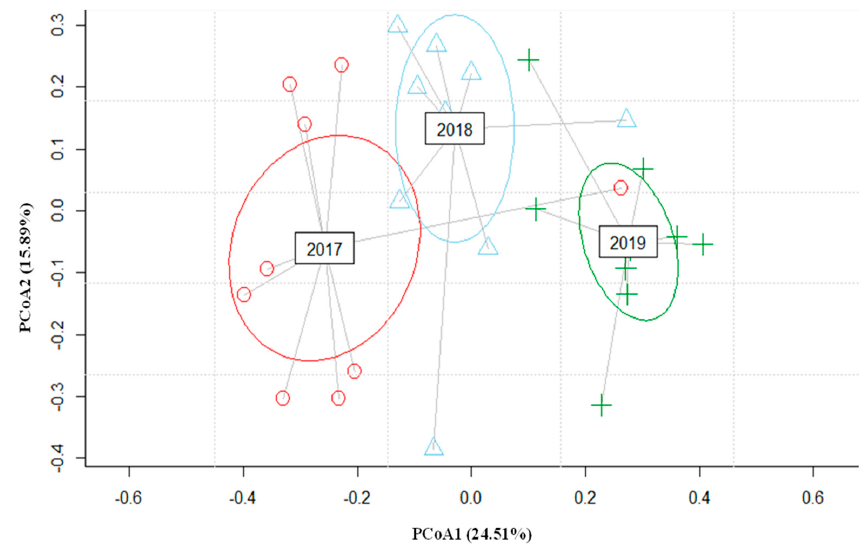
Figure 3. NMDS biplot based on Bray–Curtis dissimilarity index for three periods, shown by different colors and symbols.